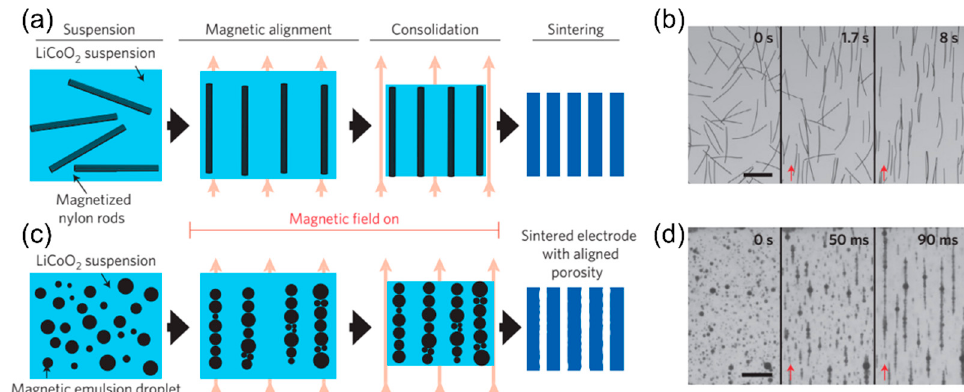
Figure 7. ( a ) Magnetic-field-assisted low-tortuous electrode structure using magnetized nylon rods and ( b ) magnetized nylon rods in water before and after applying the magnetic field (scale bar, 500 μ m). ( c ) Magnetic-field-assisted low-tortuous electrode structure using magnetic emulsion droplets and ( d ) magnetic emulsion droplets before and after applying the magnetic field (scale bar, 75 μ m). Reproduced with permission from ref. [103]. Copyright 2016, Springer Nature.